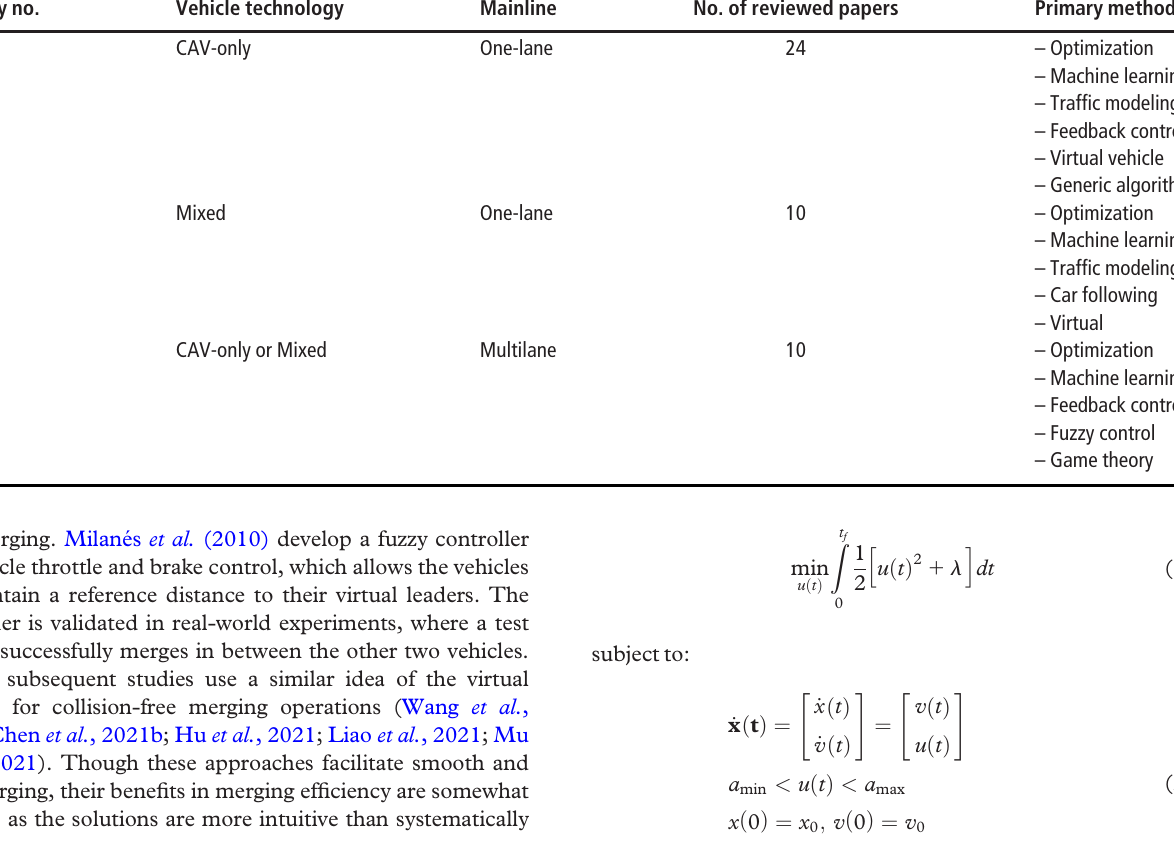
Table 1 Number of papers reviewed for different ramp merging categories Category